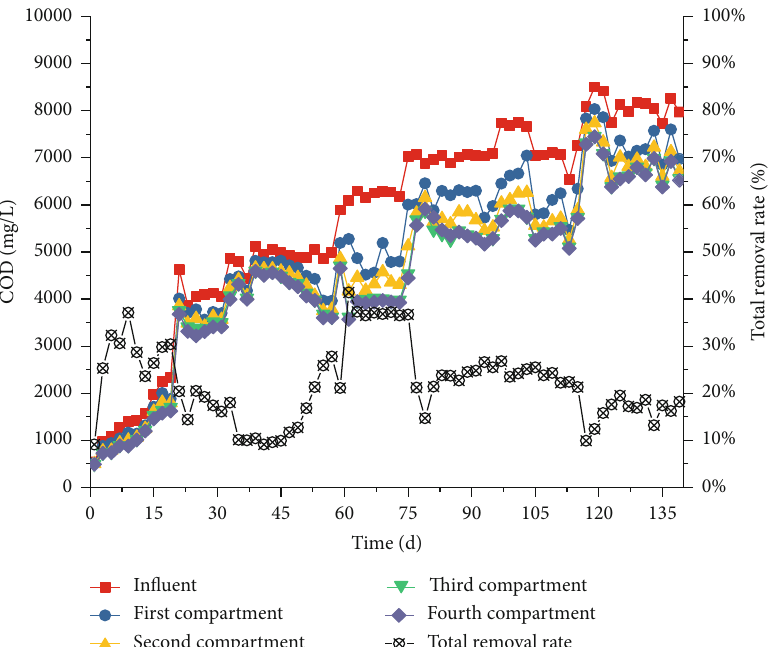
Figure 10: Variation and removal of COD in each